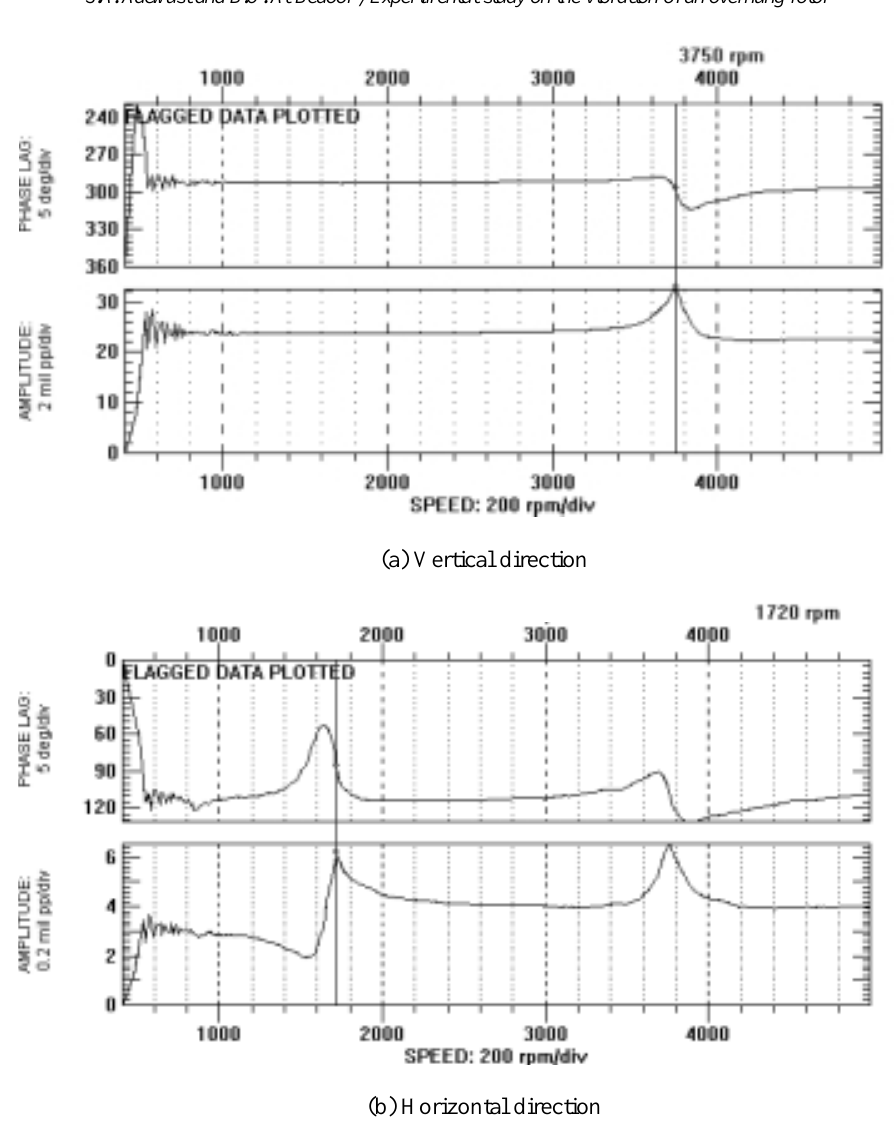
Fig. 10. Bode plots of startup data for the 2nd shaft with 4 mm notch crack with 8 kg vertical hanging side load. and horizontal directions and their percentage